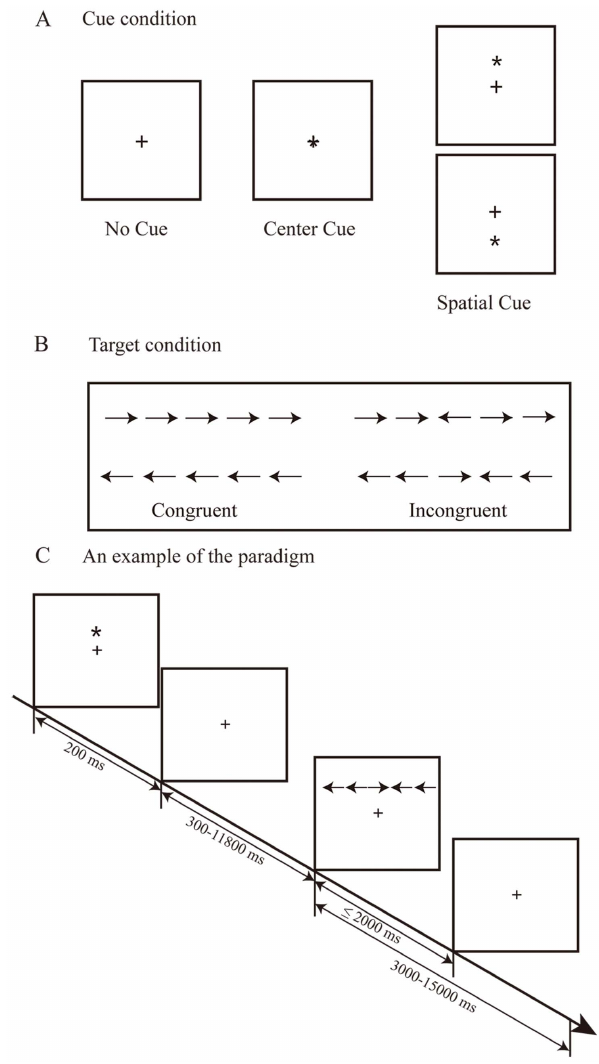
Figure 1. The attention network task (ANT) paradigm. (A)The three cue conditions in ANT. (B)The two target conditions in ANT. And (C) an example of the ANT paradigm: a spatial cue is presented followed by an incongruent target condition.